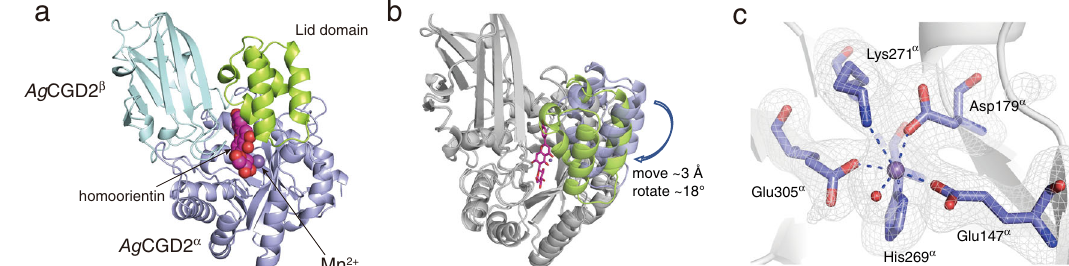
Fig. 3 Crystal structures of C -deglycosylation enzymes. a Heterodimer structure of Ag CGD2. The β -sandwich structure of Ag CGD2 β is shown in pale blue and the TIM barrel structure of Ag CGD2 α in purple. The lid domain of Ag CGD2 α is shown in light green. b Conformational change of the lid domain of Ag CGD2 α upon substrate binding. The lid domains in the apo structure and the structure complexed with homoorientin are shown in purple and light green, respectively. c The Fo-Fc polder omits the map of the metal-binding site of Ag CGD2 α . The electron density map of the ligands is represented by a gray mesh, contoured at + 3.0 sigma. Purple and red balls represent Mn 2 + and